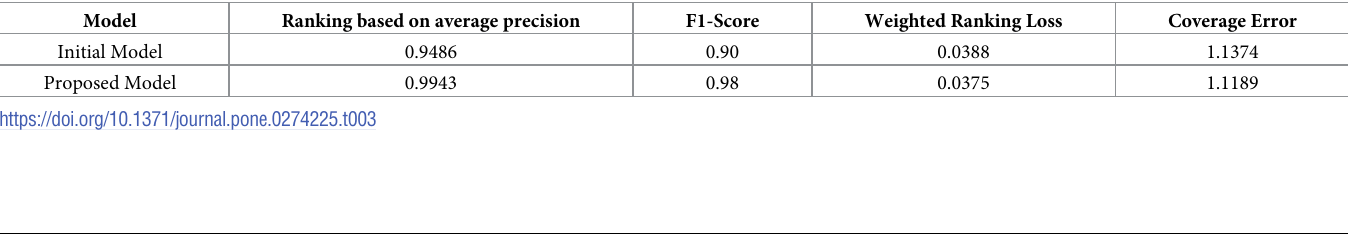
Table 3. Results of the proposed model with the initial